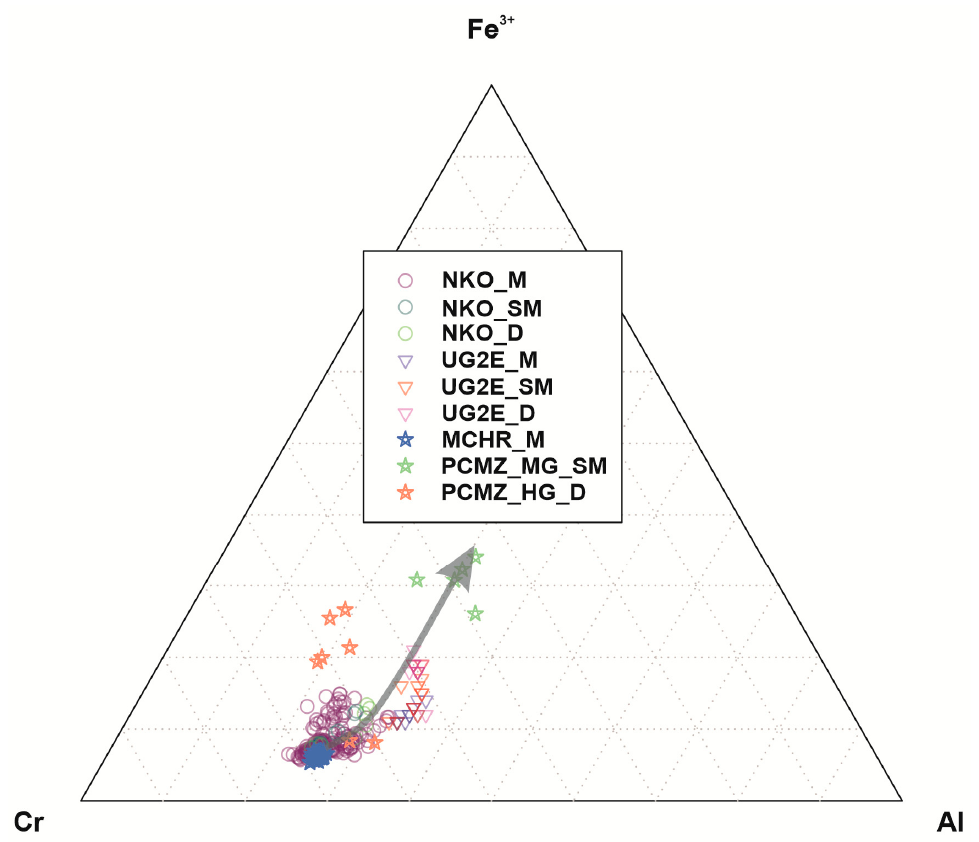
Figure 5. Cr-Al-Fe 3+ ternary plot based on chromite cation proportions. NKO represents data from [36]. UG2E represents data from [21].